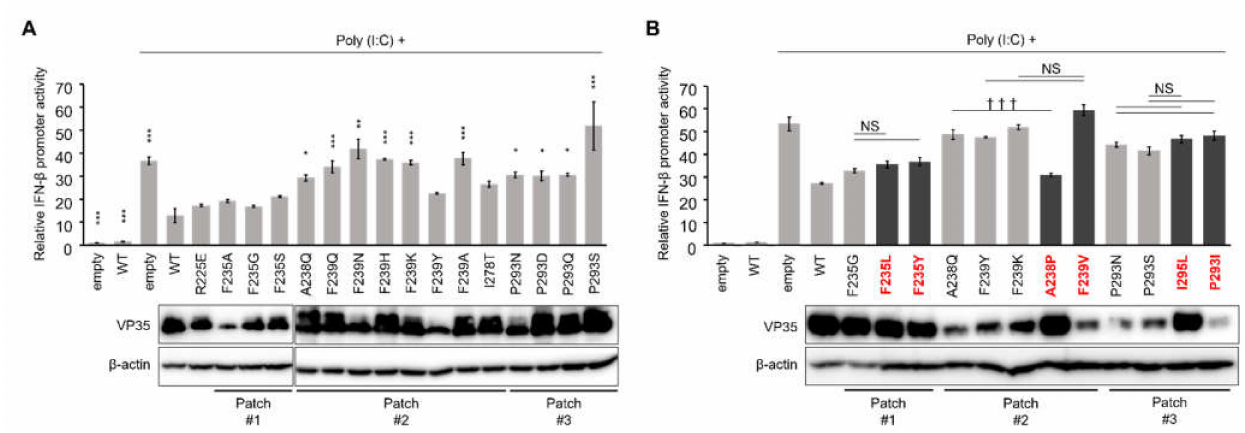
Figure 4. Antagonism of IFN production attenuated by hydrophobic patch modifications in VP35 IID. IFN- β promoter activity was assessed for patch-disrupted mutants alone ( A ) and together with patch-retained mutants ( B ) in the reporter assay. HEK293 cells were transfected with an empty vector (empty), WT-, or mutant VP35-expressing plasmids, and expression plasmids of Renilla luciferase along with pIFN β -luc. IFN- β promoter was activated by poly(I:C) stimulation. IFN- β promoter activity was quantified by measuring luciferase and normalized to the level of expression of Renilla luciferase. Error bars represent 1 standard error (SE) for three independent experiments. Lower panels show western blots for VP35 proteins and β -actin. Mutants shown in red boldface (also shown with dark bars) are those that retain the hydrophobic patch. Each bar represents mean ± SE from three independent experiments. Dunnett’s multiple-comparison test was used for the comparison to WT stimulated with poly(I:C) (* p < 0.05, ** p < 0.01, *** p < 0.001) ( A ) and the Tukey– Kramer test for comparisons between the mutants (i.e., patch-disrupted and patch-retained mutants in each amino acid position (††† p < 0.001, NS: No significant difference) ( B